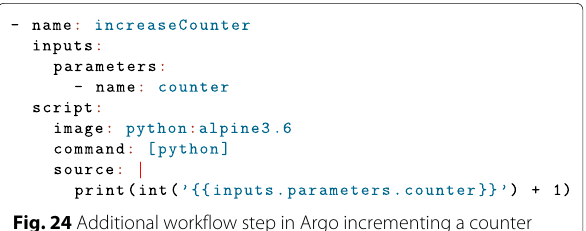
Fig. 24 Additional workflow step in Argo incrementing a counter